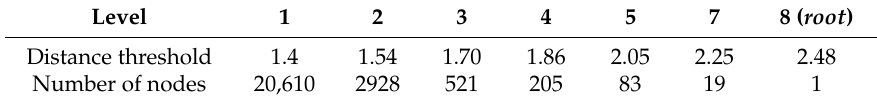
Table 1. Distance thresholds and the number of nodes for each tree level of the MNIST dataset.